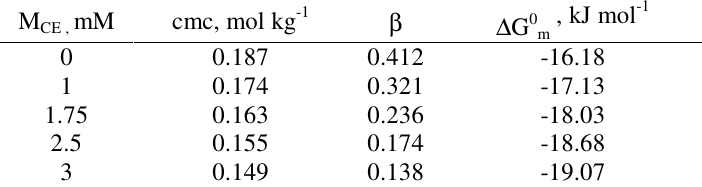
Figure 3. Concentration department of cmc and β . Table 1. Values of cmc , degree of counterion dissociation ( β ) and change in free energy of micellization, ∆ G 0 , for TEAB/ CE/ W at various concentration of crown m